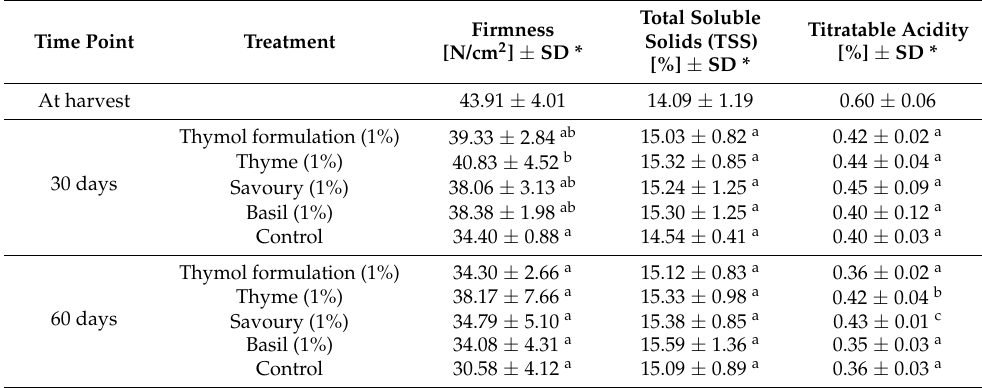
Table 2. Firmness, total soluble solids, and titratable acidity of apples ‘Opal’ treated with essential oil biofumigation and stored at 1 ± 1 °C with 95% relative humidity for 60 days.